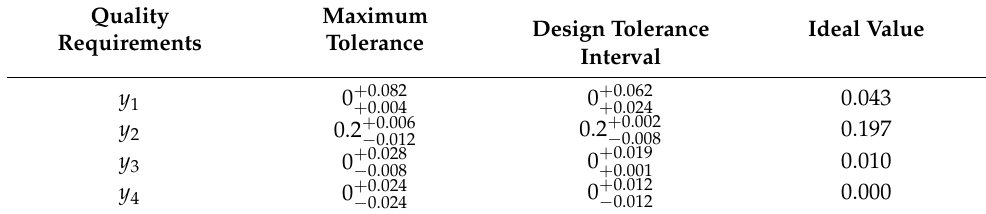
Table 2. Related data of each QR of the